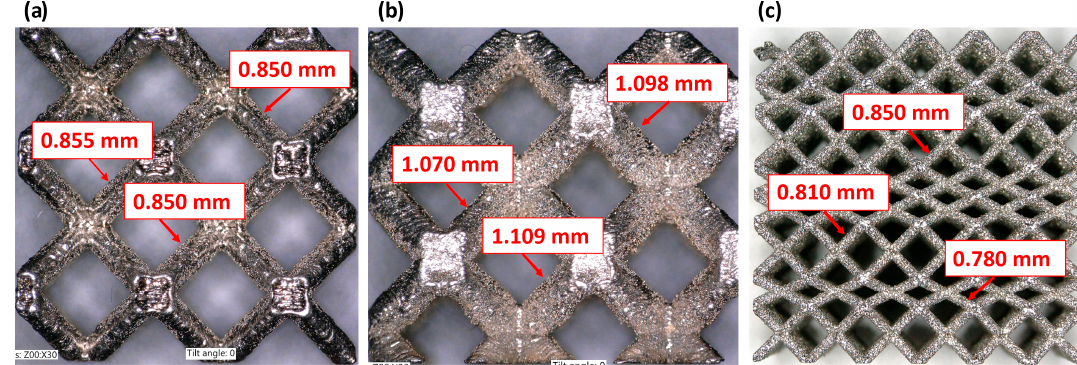
Figure 4. The dimensional deviations of strut thickness: ( a ) frontal-view of regular structure, ( b ) side-view of regular structure and ( c ) frontal-view of structure with the discrete topology .